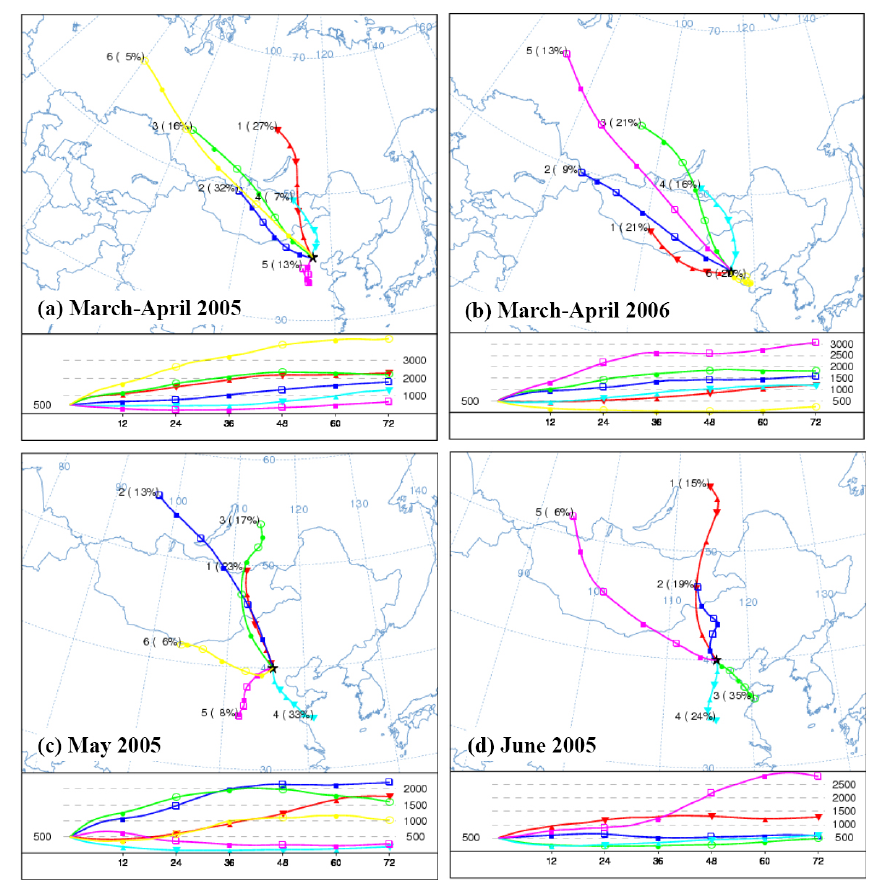
Fig. 4. Clusters of air mass backward trajectories arriving at 500m above ground level at Beijing for (a) 4 March–6 May, (c) 7–31